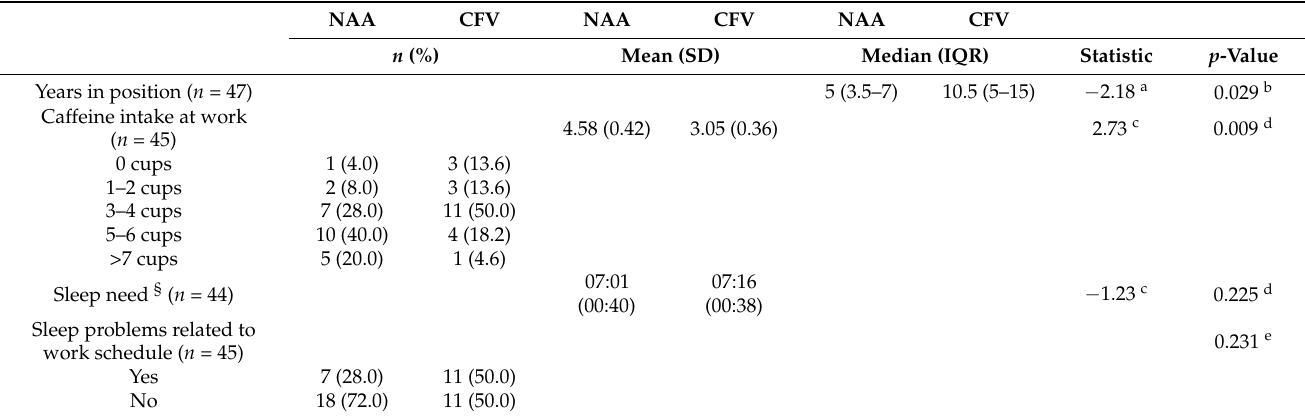
Table 1. Descriptive statistics of years in position, caffeine intake at work, sleep need, and sleep problems related to work schedule for pilots in The Norwegian Air Ambulance (NAA; n = 25) and Christophorus Flugrettungverein (CFV; n =